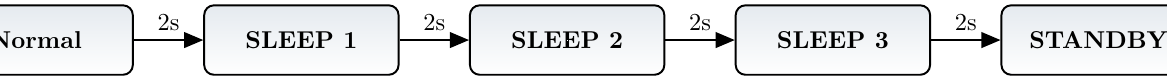
Figure 5. Control flow of SPU modes test.